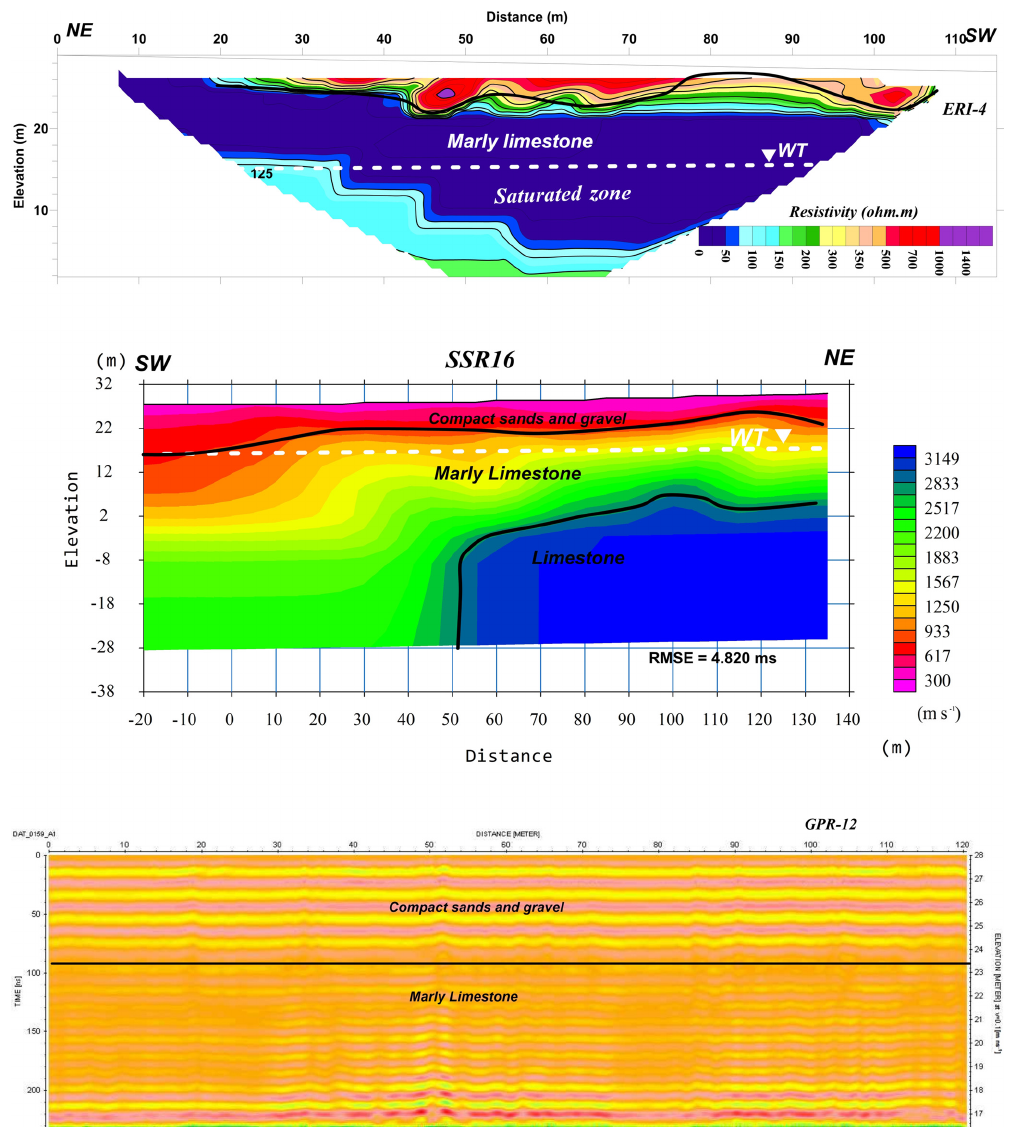
Figure 9. ERI, SSR, and GPR profiles in the Valley Temple of